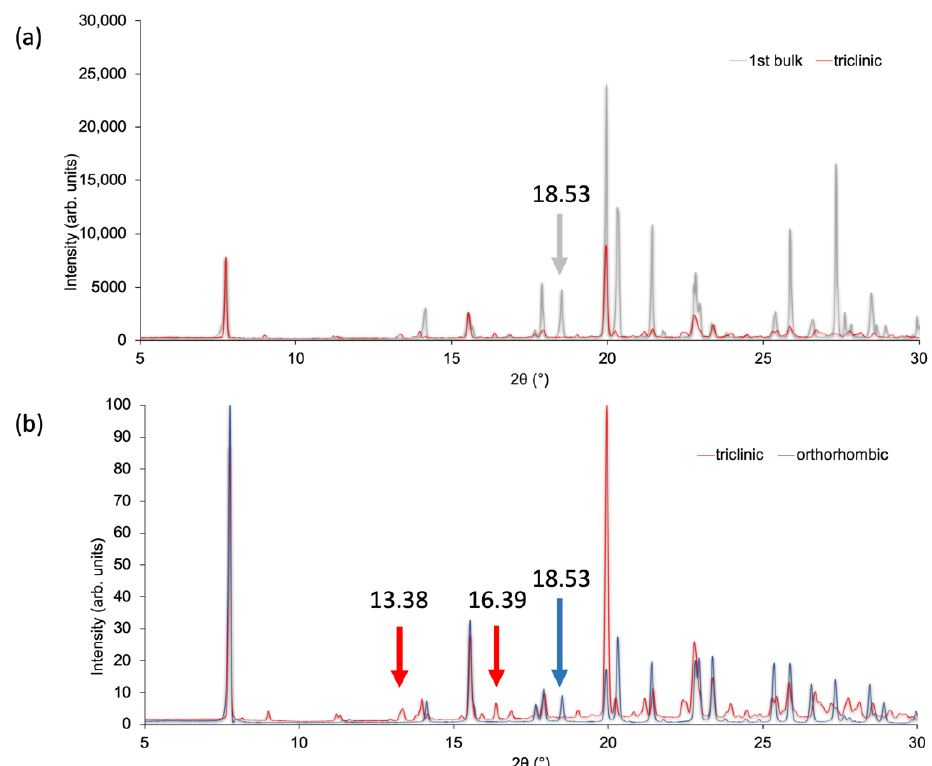
Figure 7. ( a ) Comparison of the PXRD patterns (expansion of the range between 2θ = 5–30°) for the